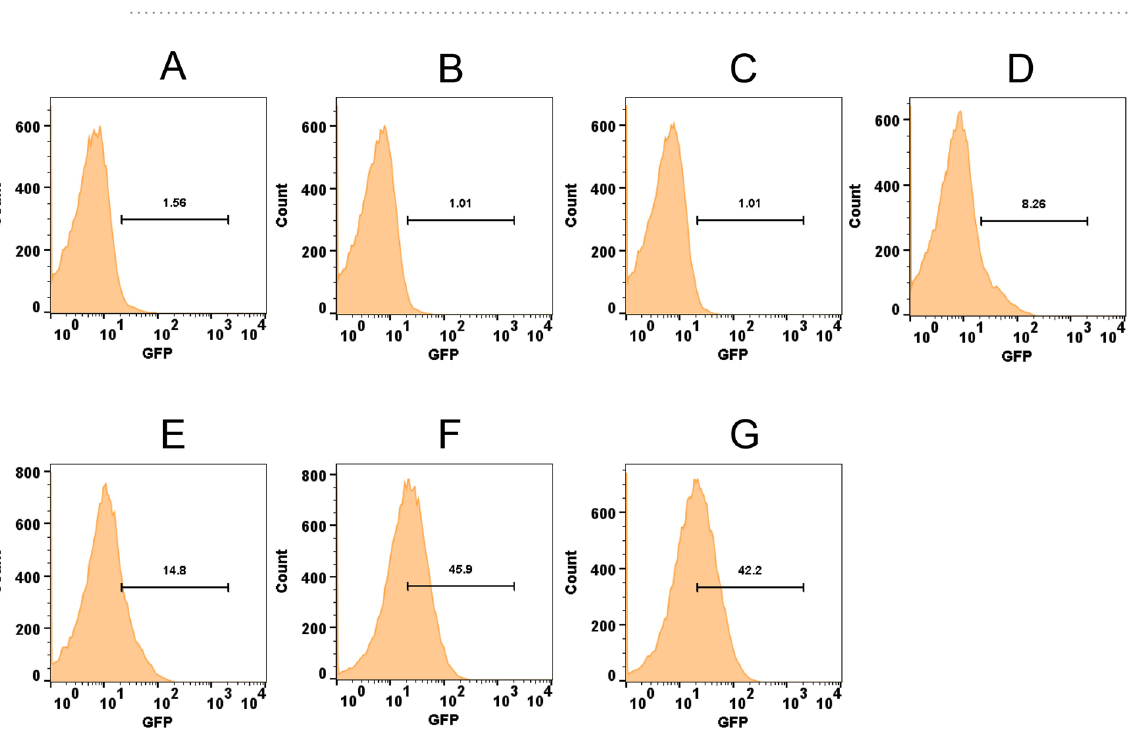
Figure 4. Induction of GFP in M . smegmatis strain MSOHG3 exposed to t -BHP for different time points. MSOHG3 carrying ohrR - pohr - gfpuv fusion was exposed to 100 µ M of t -BHP for different time periods at 37 °C. Flow analysis was performed in BD FACSAriaII using excitation and emission wavelengths of 395 nm and 509 nm, respectively. ( A ) un-induced control bacteria; ( B–G ) bacteria exposed to t -BHP for 0, 15, 30, 60, 120, 240 minutes,